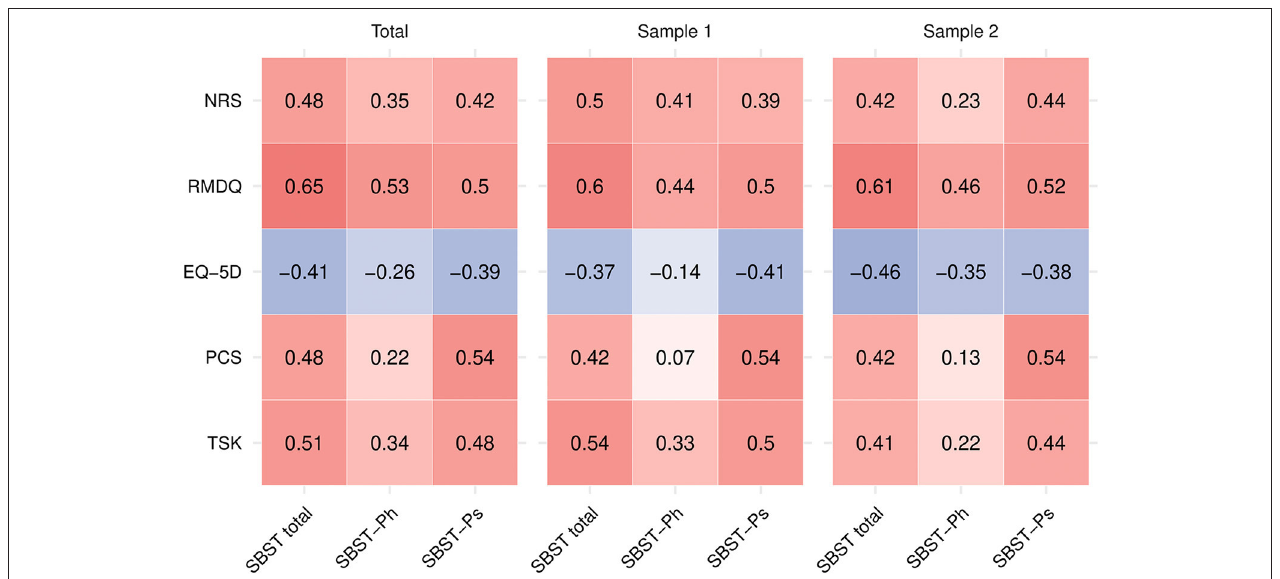
FIGURE 2 | Correlations between the Start Back Screening Tool and the comparator instruments. PCS, Pain Catastrophizing Scale; RMDQ, Roland Morris Disability Questionnaire; TSK, Tampa Scale for Kinesiophobia; NRS, Numeric Rating Scale; SBST-Ph, Start Back Screening Tool—Physical subscale; SBST-Ps, Start Back Screening Tool—Psychological